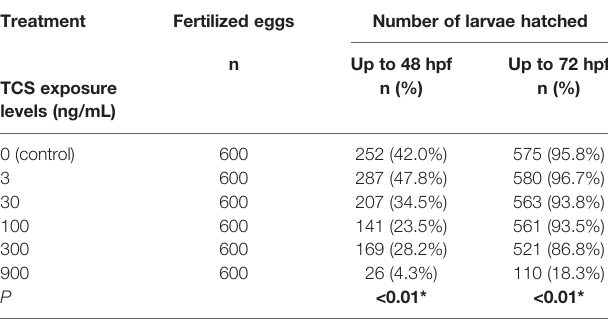
TABLE 1 | The association of TCS exposure concentration and the hatching rate of zebra fi sh embryos within 48 and 72 h. Treatment Fertilized eggs Number of larvae